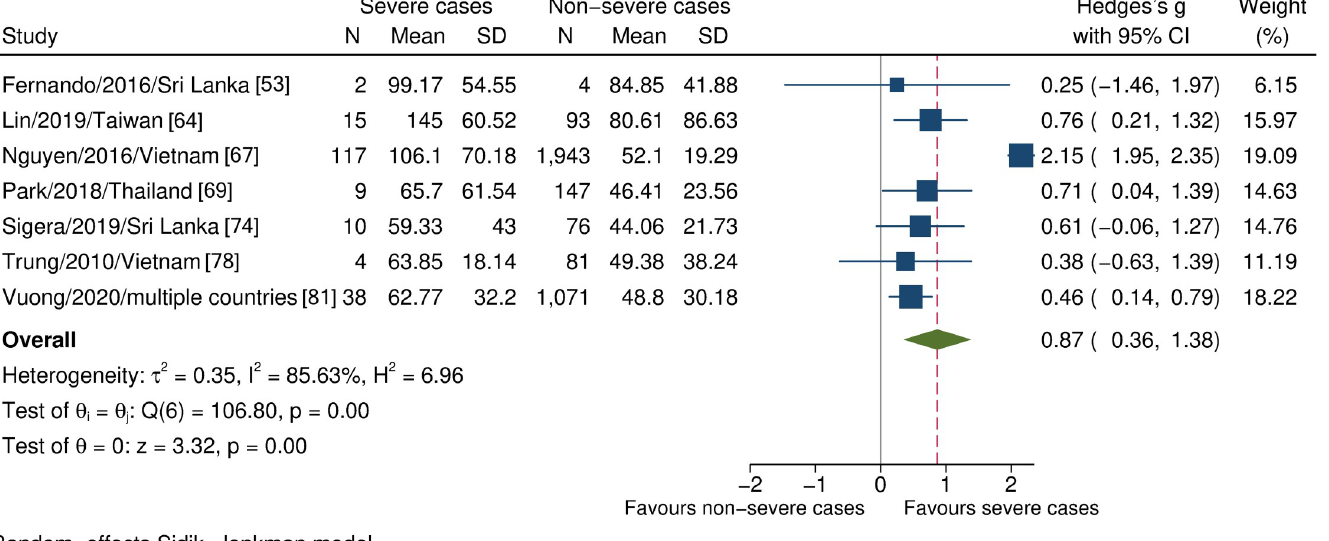
Fig 7). Seventeen studies reported the alterations of 25 immune mediators. Four eligible biomark- ers, CRP, TNF- α , IL-10, and IFN- γ , found no significant variation in marker levels when com- paring severe and non-severe dengue (S8–S11 Figs). Eight studies correlated either the quantity of virus or NS1 antigen in the bloodstream with severity levels. The estimated effect pooled from three studies found no association between viral load in the early stage and the subsequent progression of severe dengue (S12 Fig).